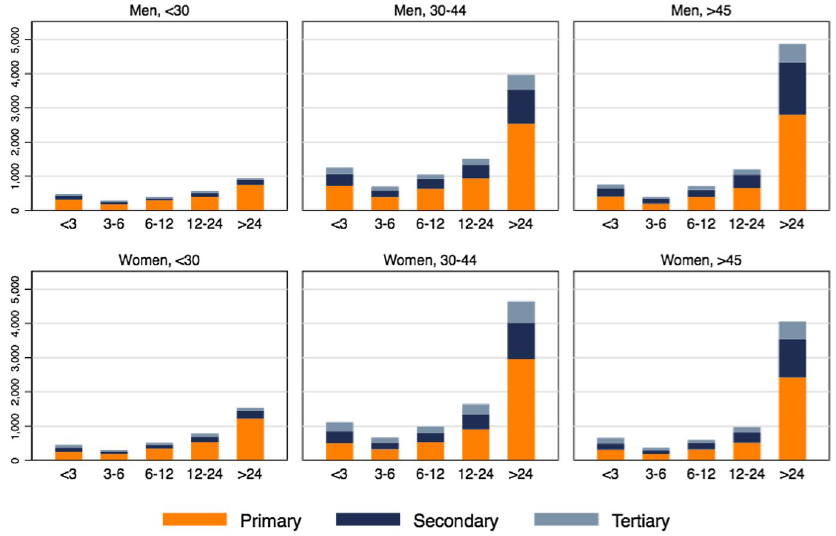
Fig. 1 Unemployed MIS recipients in the Basque Country, October 2015. Axes: gender, age, unemploy- ment duration (months), educational level. Source : Own elaboration. Lanbide microdata